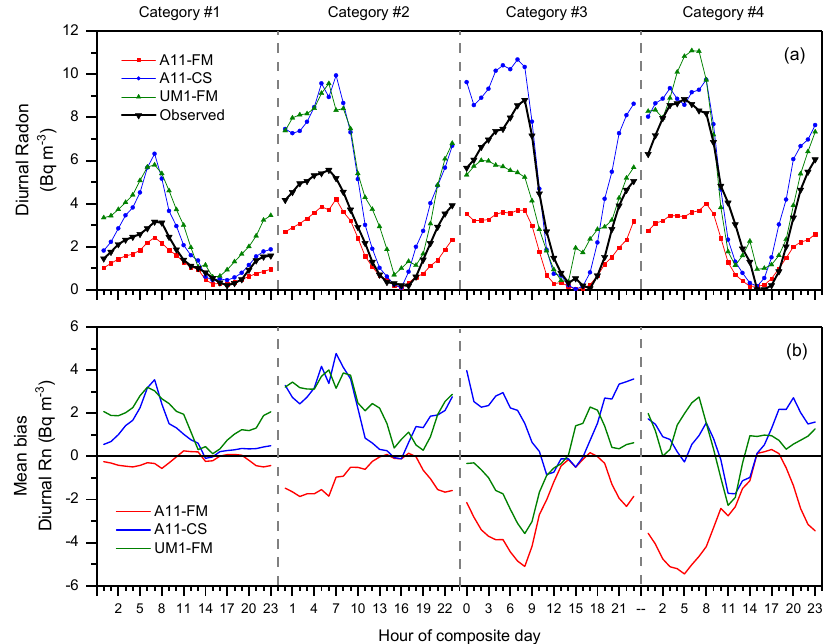
Figure 12. ( a ) Diurnal composite observed and simulated mixing-component of radon, and ( b ) diurnal mean biases of the mixing-component of radon, for each mixing category.